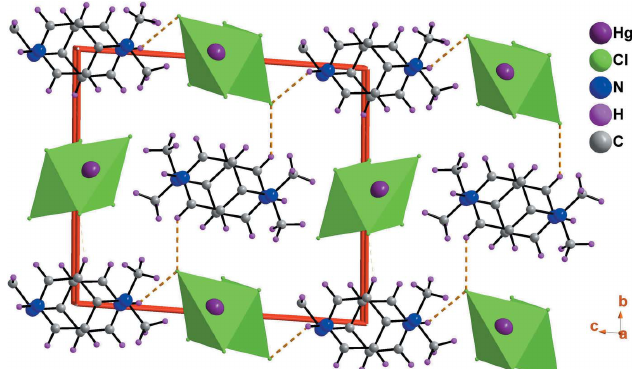
Figure 3 Structure of (I) viewed along the a axis showing the succession of mixed layers parallel to the (010) plane. The orange dotted lines indicate hydrogen bonds.